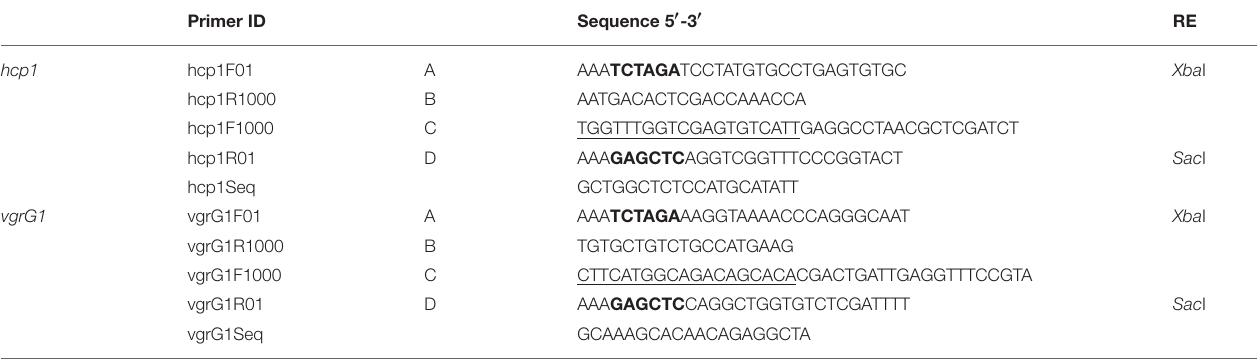
TABLE 3 | Primers used to generate and verify in-frame deletion of vAh genes. Primer ID Sequence 5 ′ -3